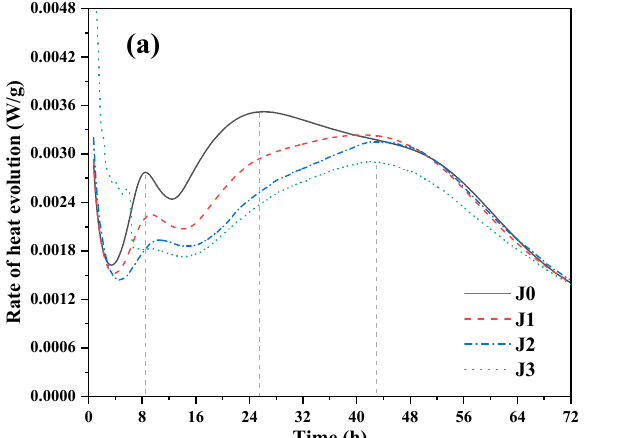
Figure 10. ( a ) Hydration exothermic rate and ( b ) total hydration heat release of M-S-H cement with SRA.